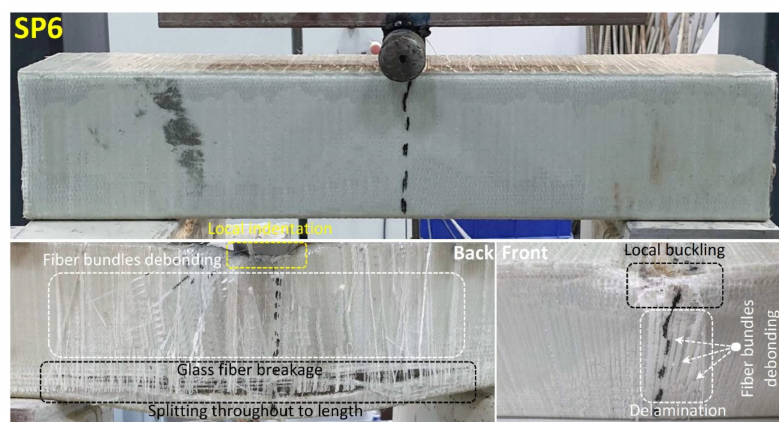
Figure 14. Undamaged and damaged specimen images of SP5.